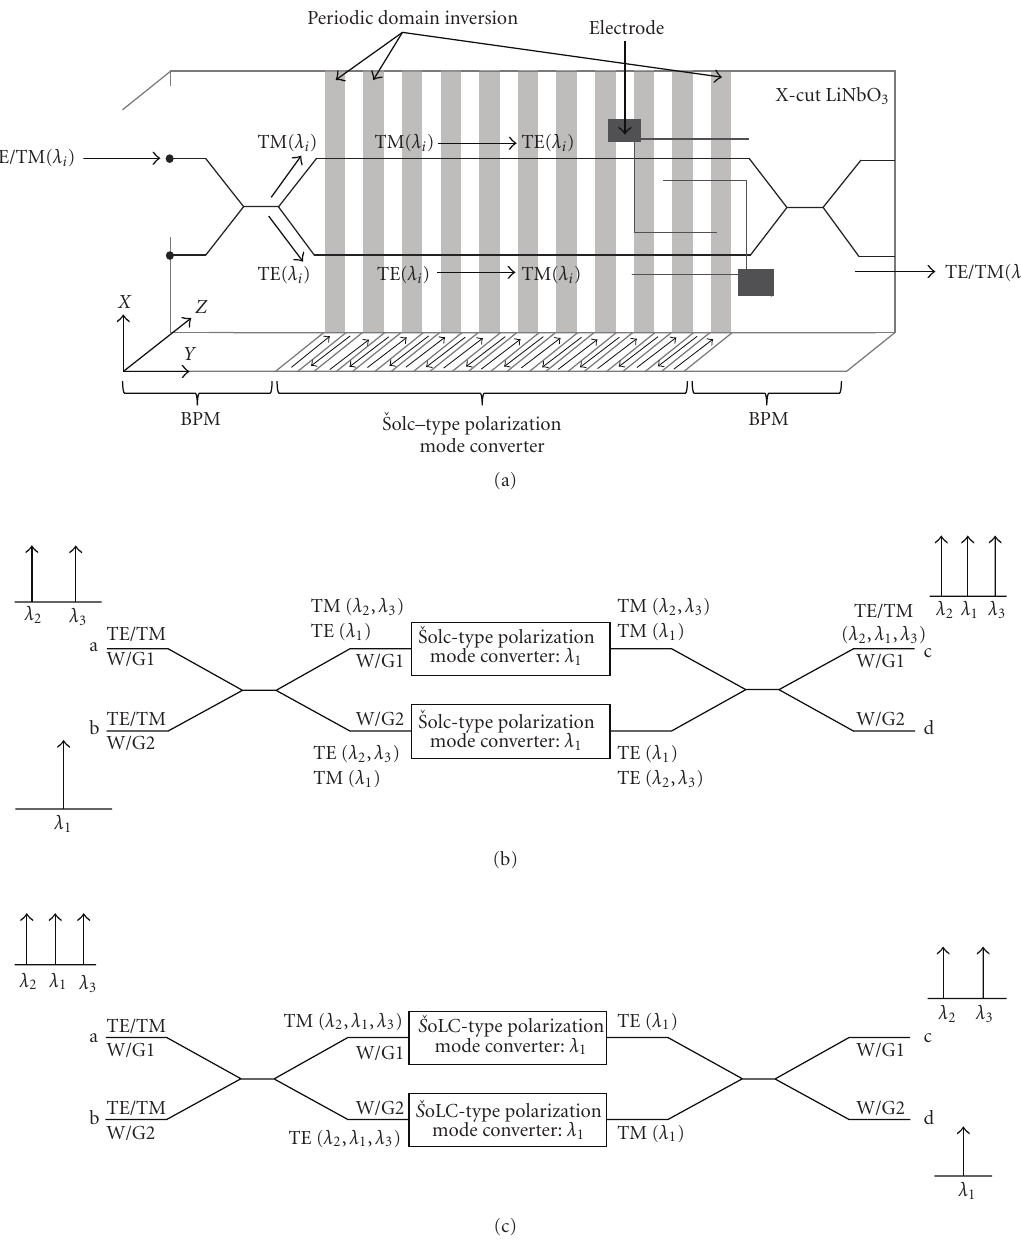
Figure 8: (a) OADM layout, and schematic configuration illustrating (b) add and (c) drop operation principles